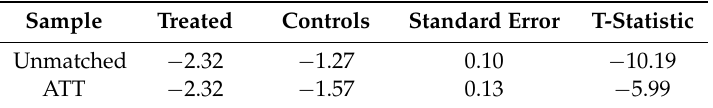
Table 2. Mean of changes in perceived job insecurity before and after